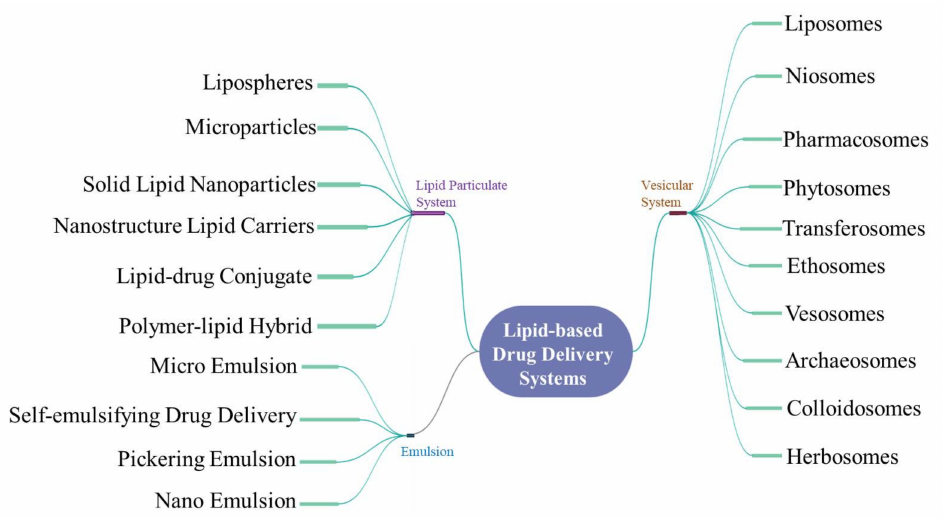
Figure 2. Mind map depicting the various lipid-based drug delivery